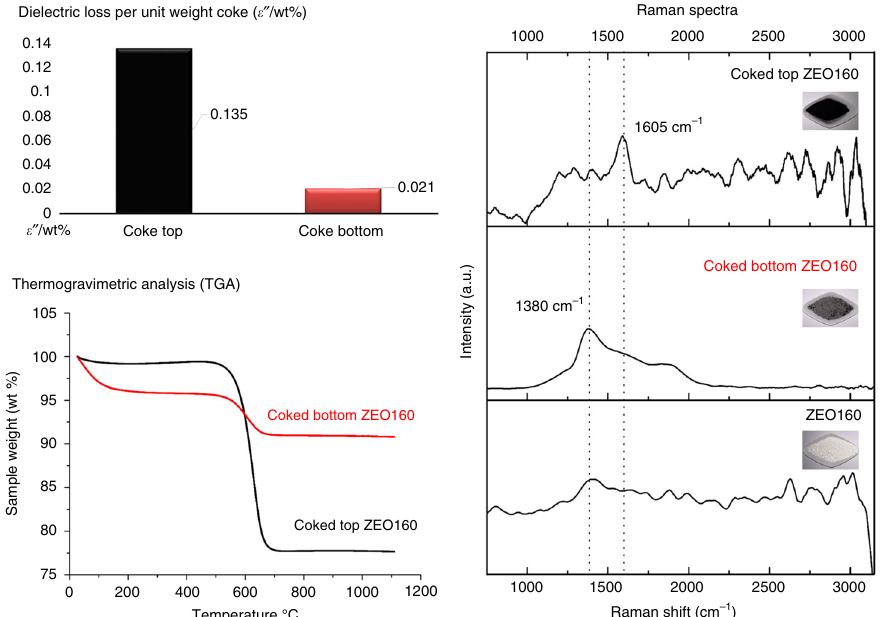
Fig. 3 ε ″ /wt% values of differently coked ZEO 160 samples with supporting TGA and Raman results. ε ″ /wt% was calculated for coked top ZEO 160 and coked bottom ZEO 160 samples, respectively. TGA (physic & chemical approaches) indicates a total coke amount (wt% of post-run sample) without speci fi cation, whereas Raman (spectroscopy methods) helps in coke species identi fi cation but lacks of quanti fi cation information